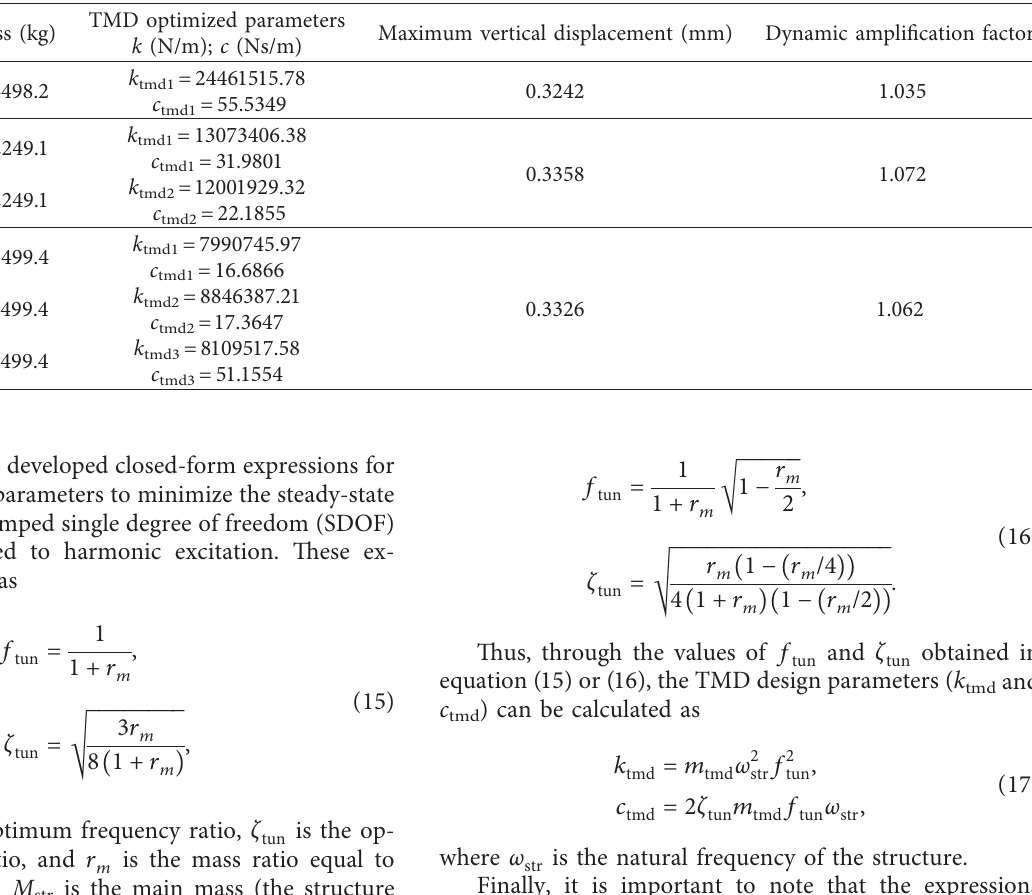
Figure 10: Convergence curves for (a) scenario 1, (b) scenario 2, and (c) scenario 3. Table 3: Results obtained with the